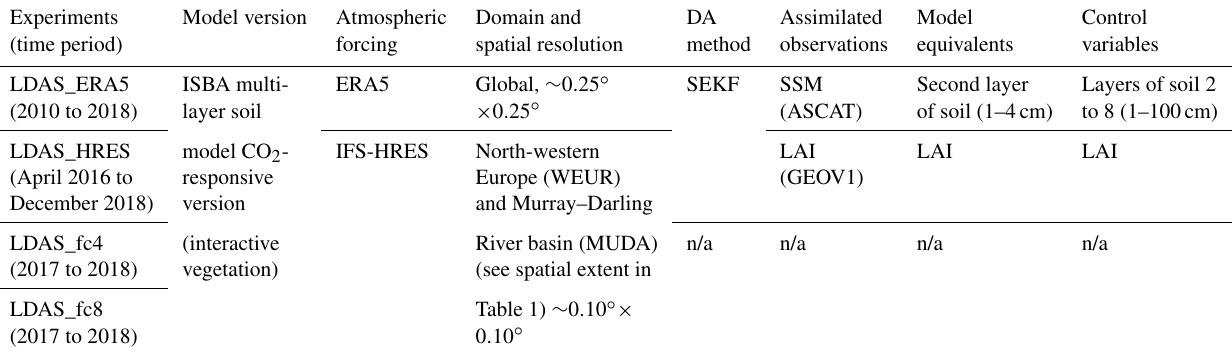
Table 2. Setup of the experiments performed in this study. LDAS_ERA5 and LDAS_HRES have an analysis (assimilation of surface soil moisture, SSM, and leaf area index, LAI) and a model equivalent (open-loop, no assimilation); LDAS_fc4 and LDAS_fc8 are model runs initialized by either LDAS_HRES open-loop or analysis. n/a stands for not